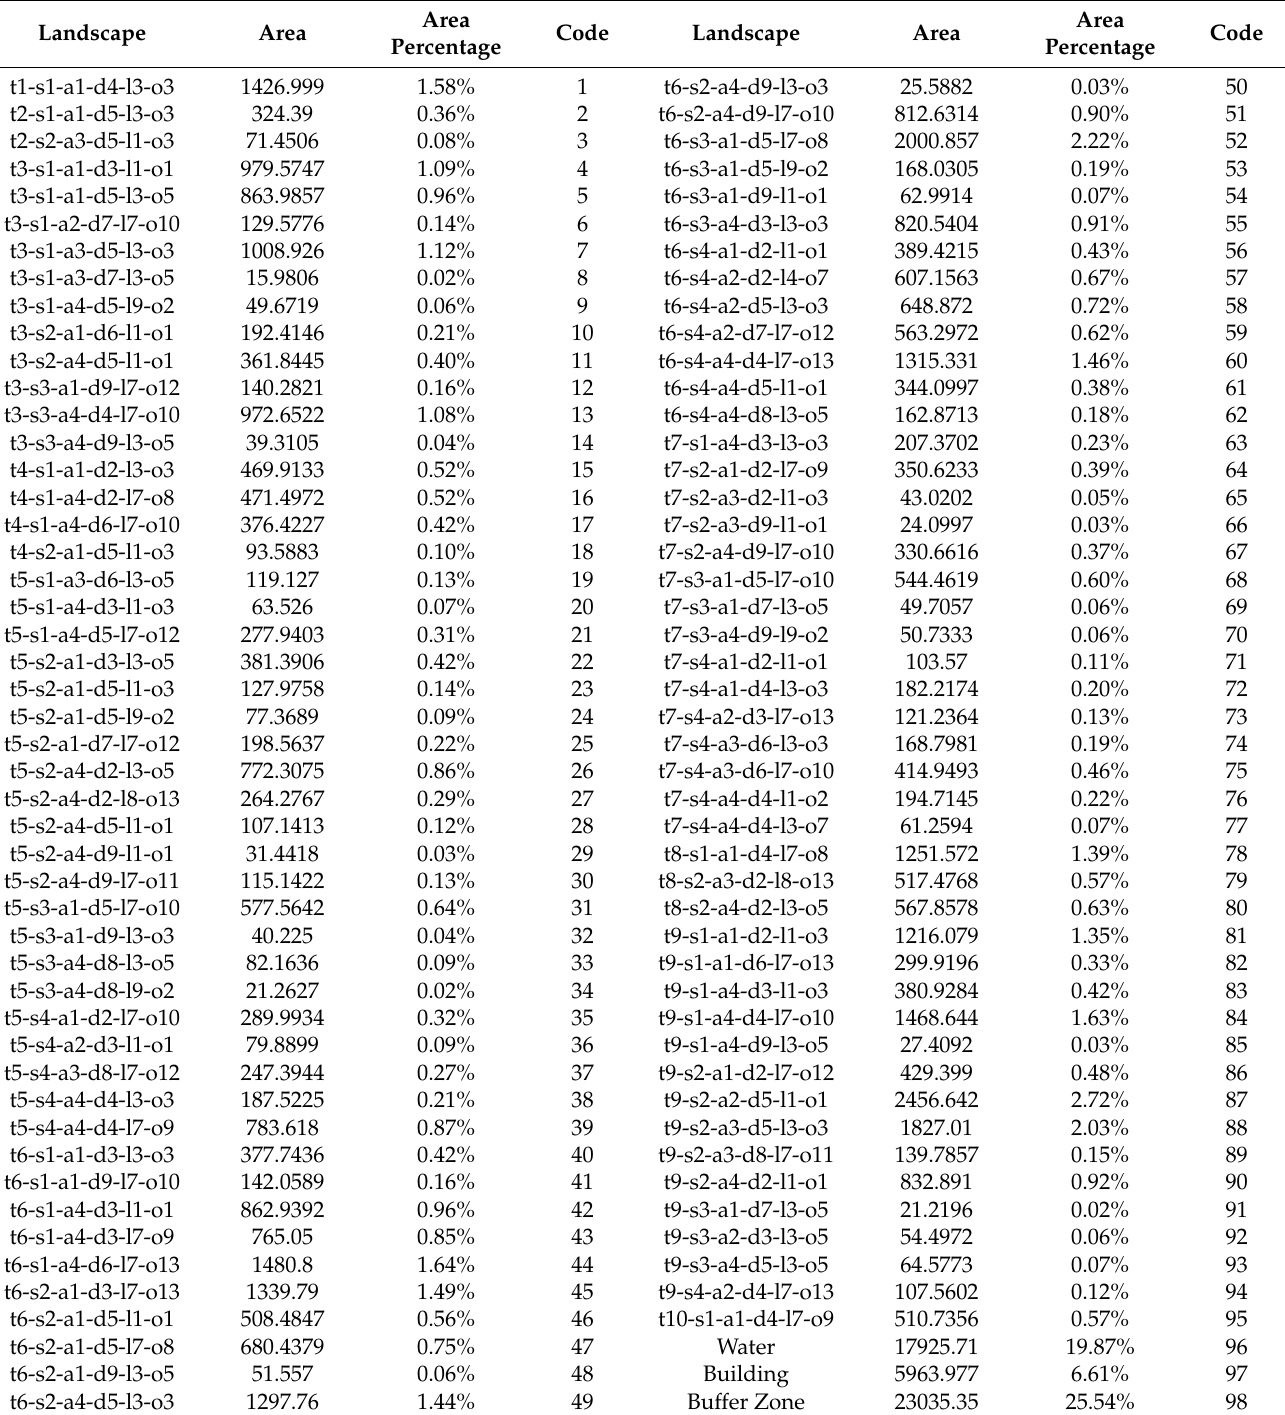
Table 5. Category of landscape